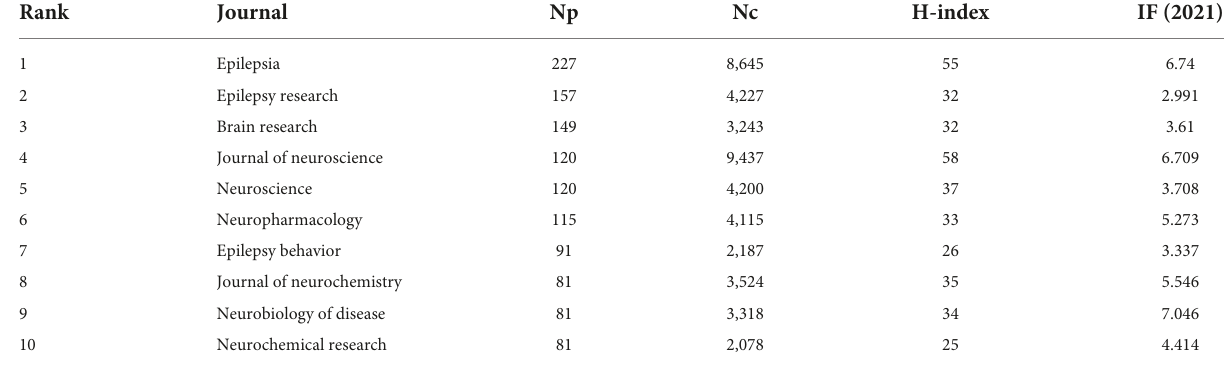
TABLE 3 Top 10 journals.